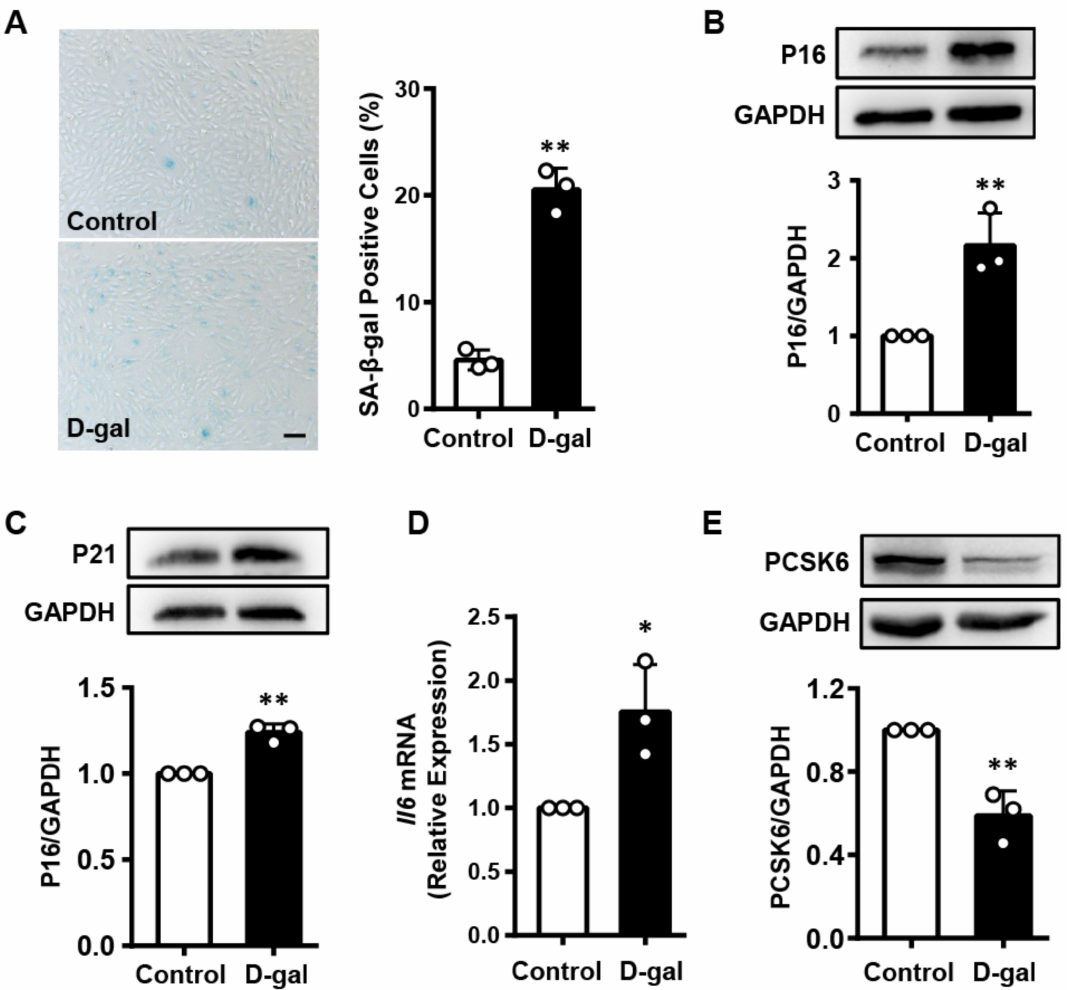
Figure 2. Decreased PCSK6 expression in senescent cardiomyocytes induced by D-gal. ( A ) SA- β -gal staining for H9c2 cells with D-gal treatment. Scale bar: 100 µ m. Percentages of blue-stained cells were calculated. ( B , C ) P16 and P21 protein levels in D-gal-treated H9c2 cells were estimated by densitometric quantification of Western blots. ( D ) Il6 mRNA expression in H9c2 cells treated with D-gal by qPCR. ( E ) Western blot analysis of PCSK6 protein expression in H9c2 cells in the presence of D-gal. Values are mean ± S.D. * p < 0.05, ** p < 0.01 vs.